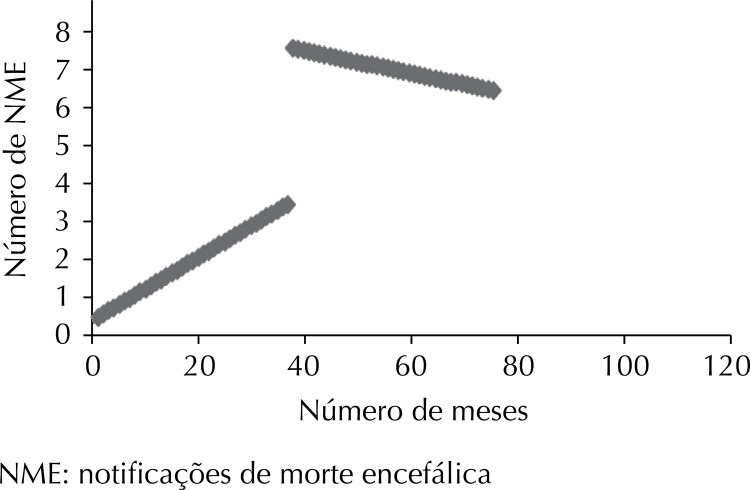
Número de notificações de morte encefálica antes e depois do projeto no Hospital 2. São Paulo, 2005 a 2011.